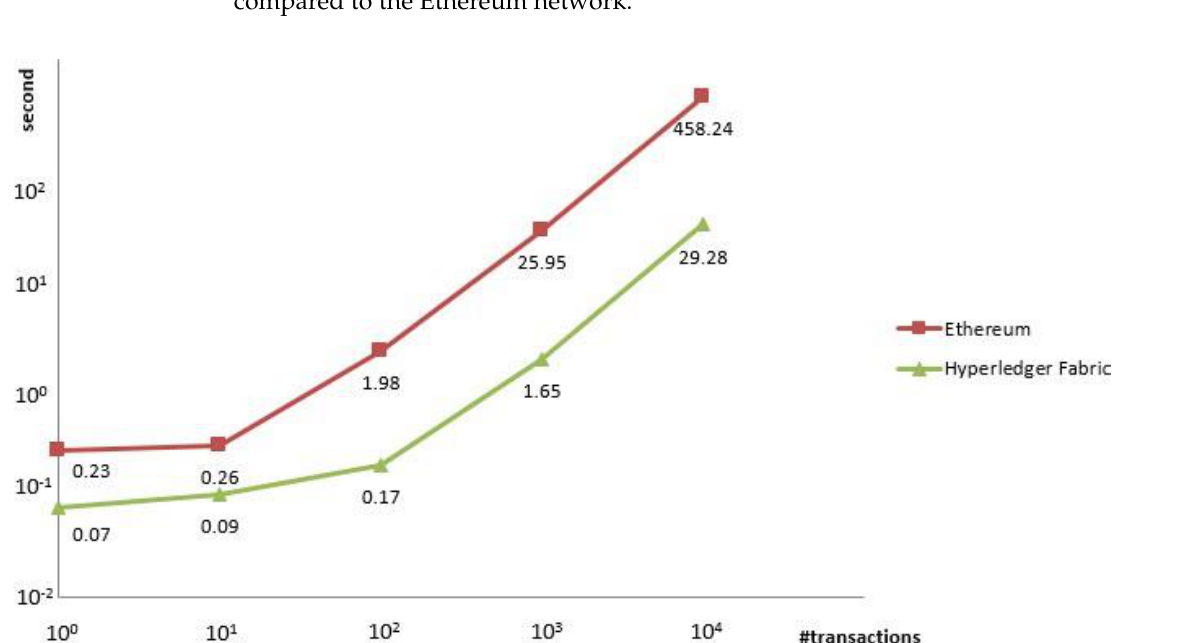
Figure 7. Probability of corrected data blocks. 0.50.55 0.6 0.65 0.7